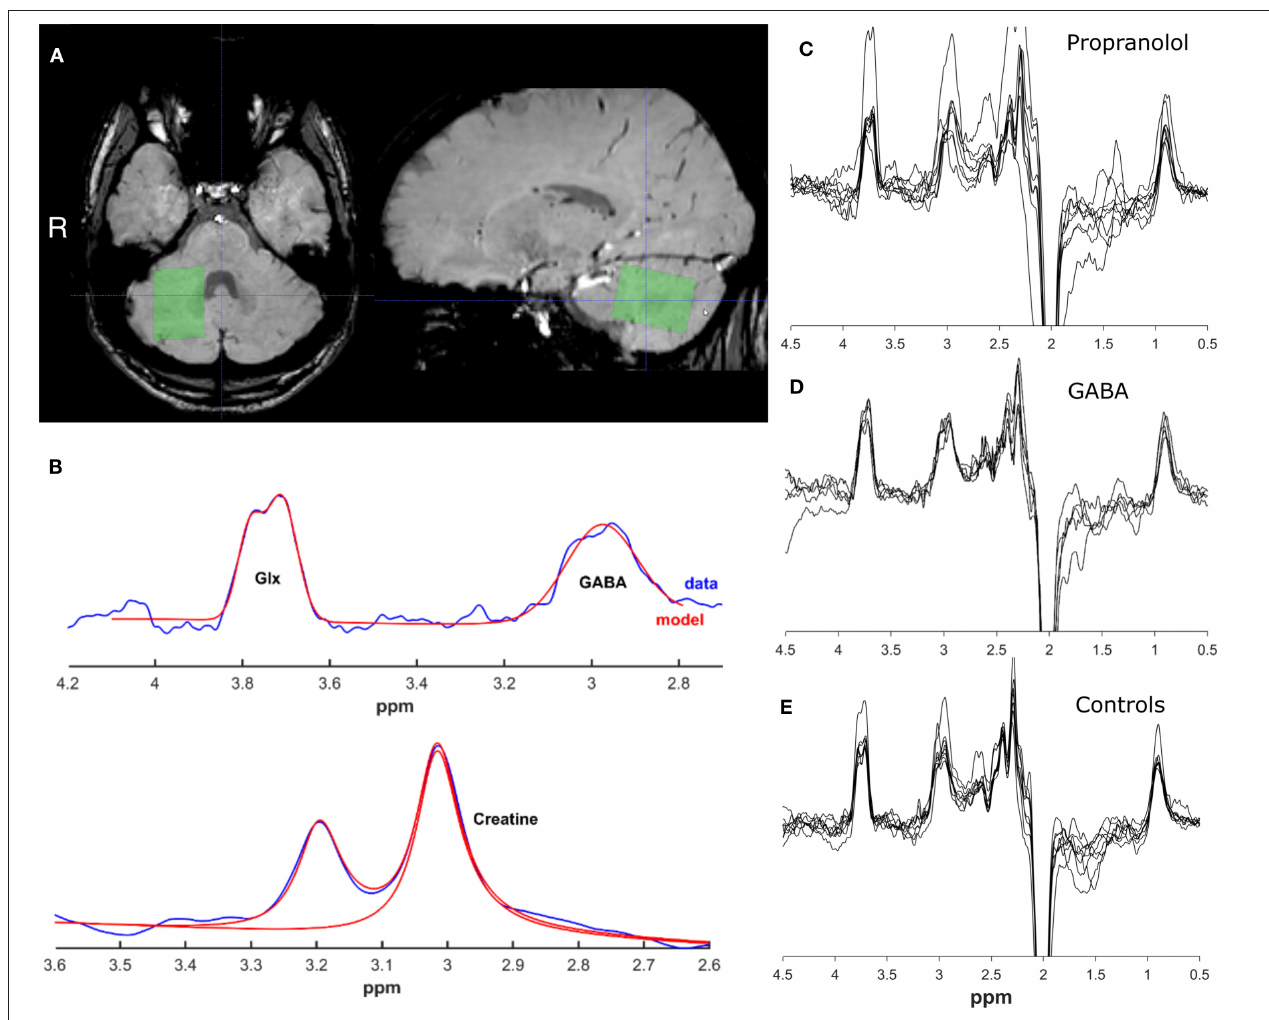
FIGURE 1 | Representative voxel placement and spectra. (A) Location of MRS voxel on a T2*–weighted image. (B) Example spectra and fitted model for creatine, GABA + and Glx peak range. Images were created using GANNET toolbox v3.0. (C) All spectra for propranolol group (D) . All spectra for GABA group (E) . All spectra for control